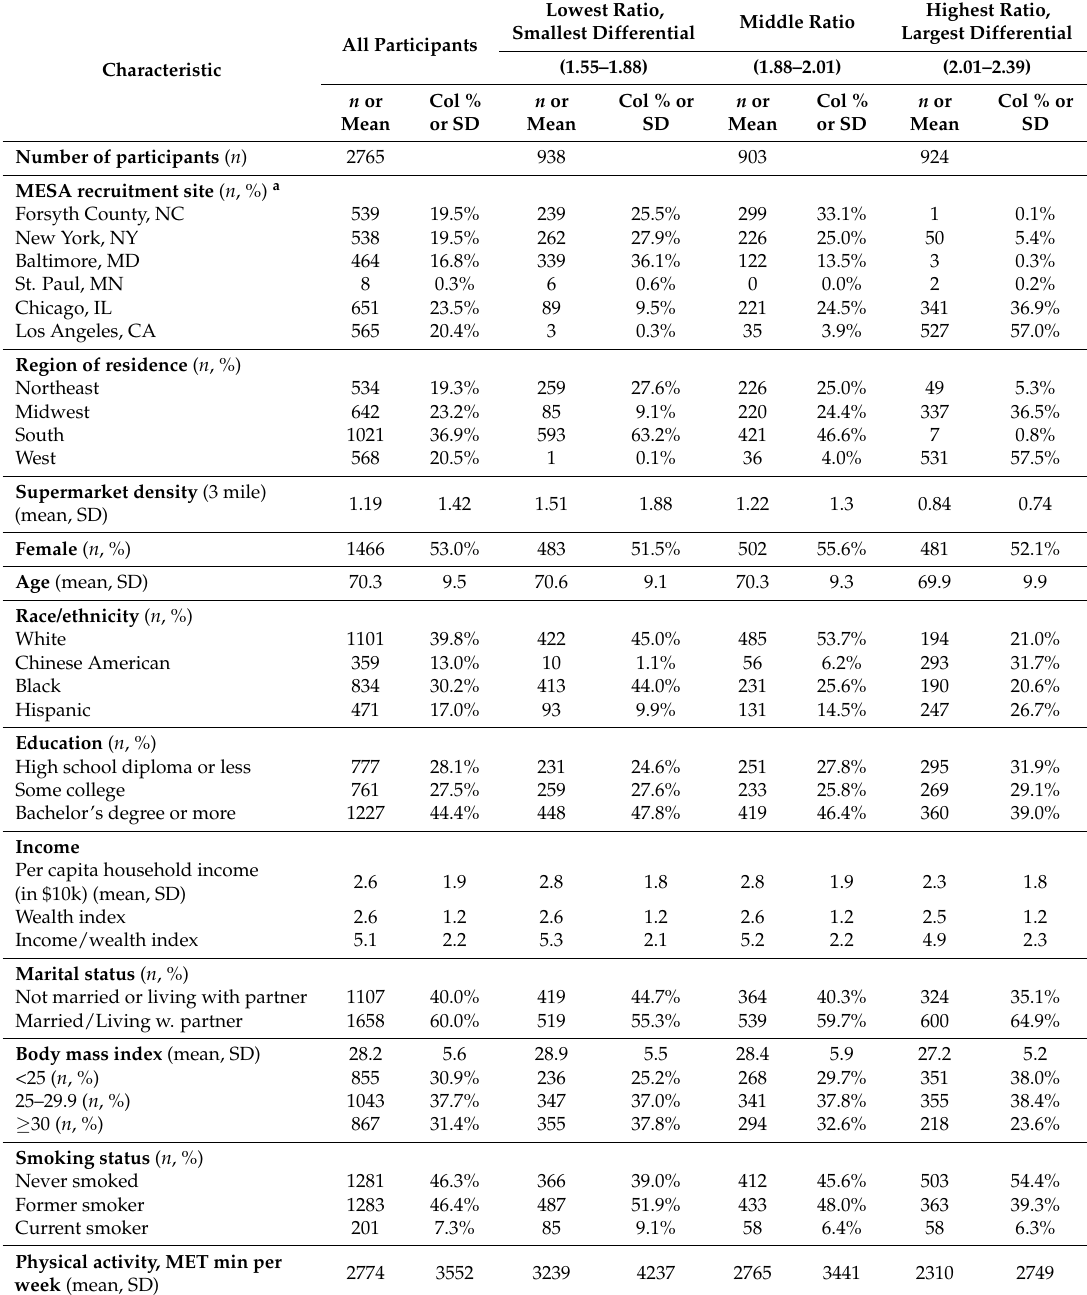
Table 1. Characteristics of the individuals included in the analysis by tertiles of healthy-to-unhealthy food price ratio ( n =